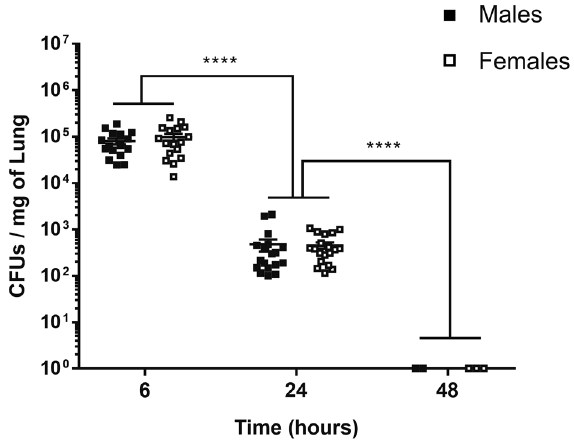
Figure 1. Bacterial count in mice lungs (detection limit: 750 CFUs). C57BL/6 male (black) and female (white) mice were infected intranasally with a sublethal dose (± 10 8 CFUs) of GBS. ****p < 0.0001 (Mann–Whitney U test). Data are representative of three pooled